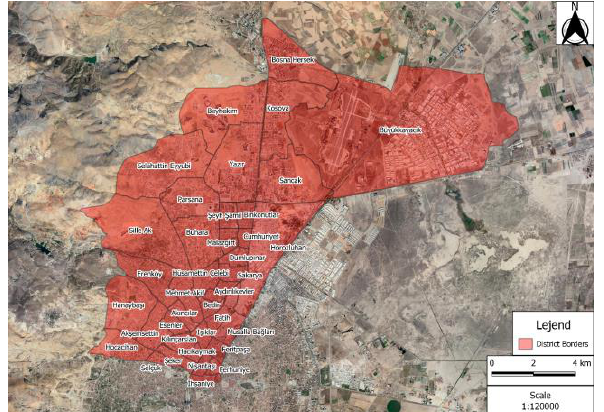
Figure 2. The central neighborhoods of the Selcuklu District, Konya,